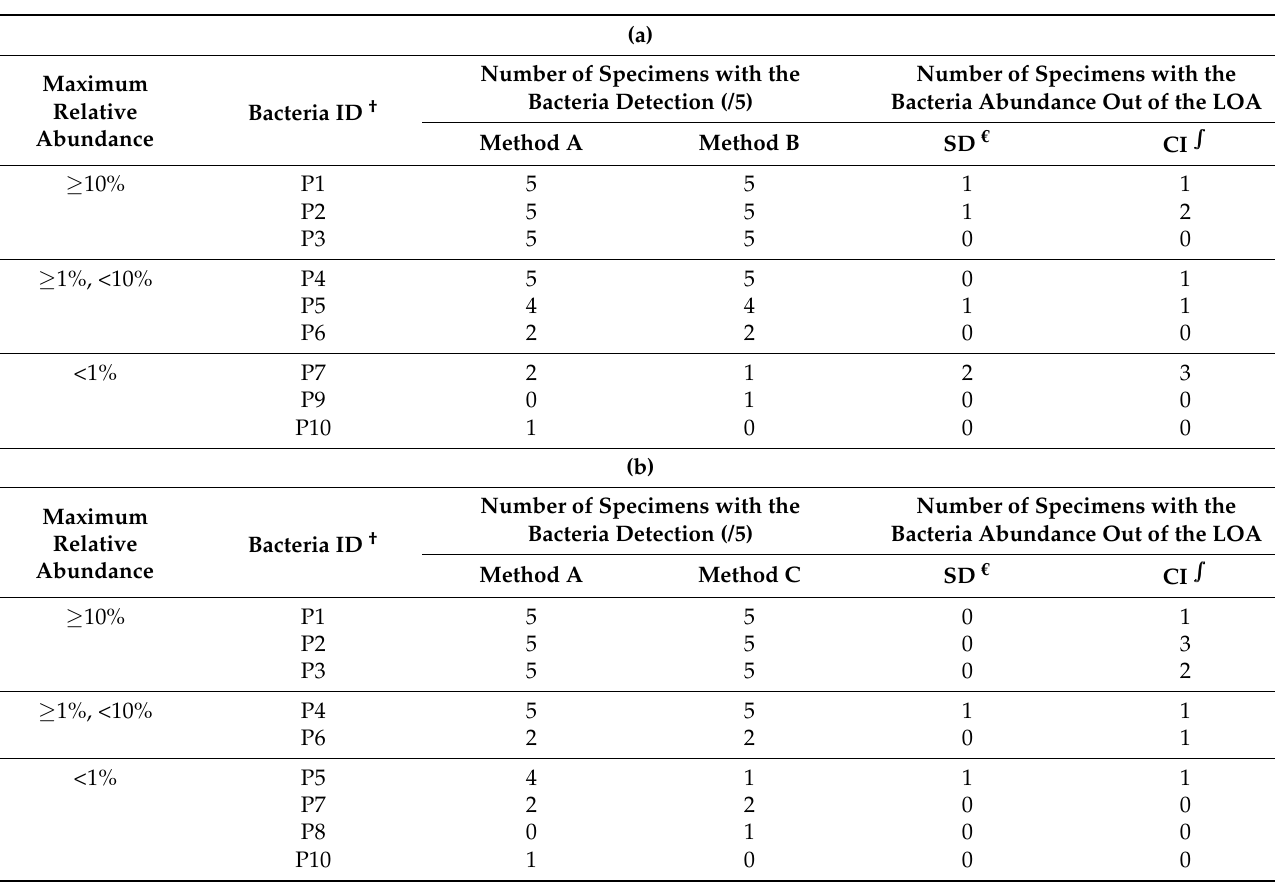
Table 2. Research I: Summary of bacteria detection and Bland–Altman plotting results (Methods A–B ( a ) and Methods A–C ( b ) at the phylum level.